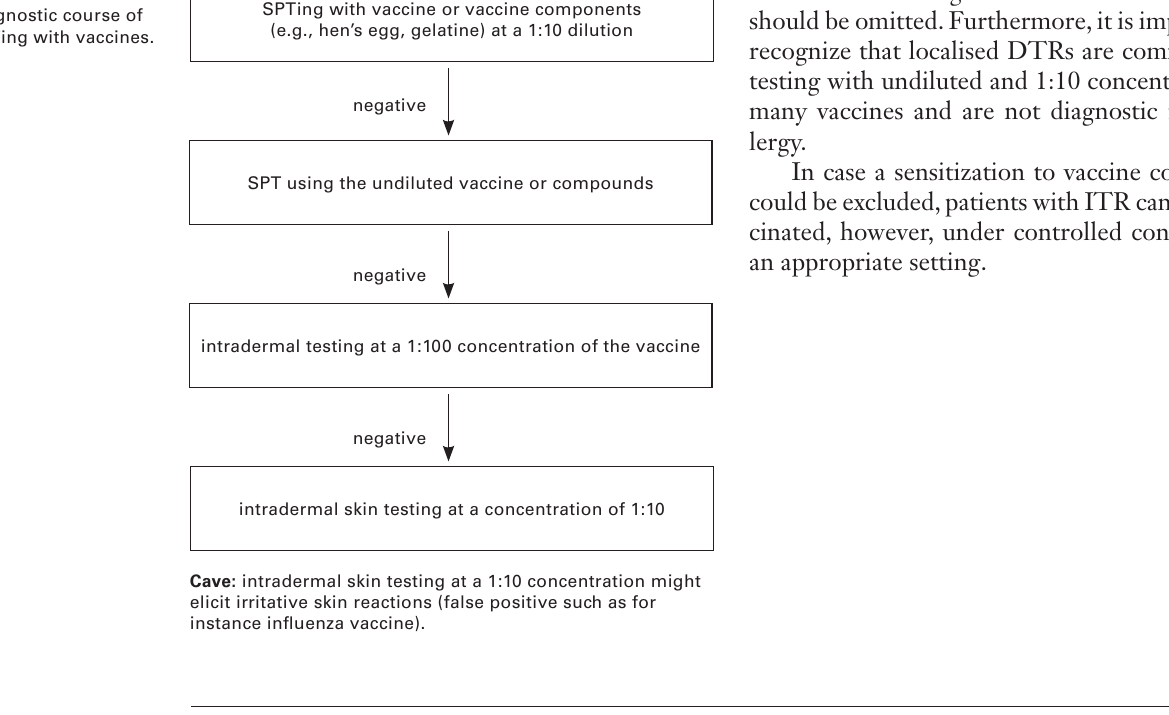
Diagnostic course of SPTing with vaccines.